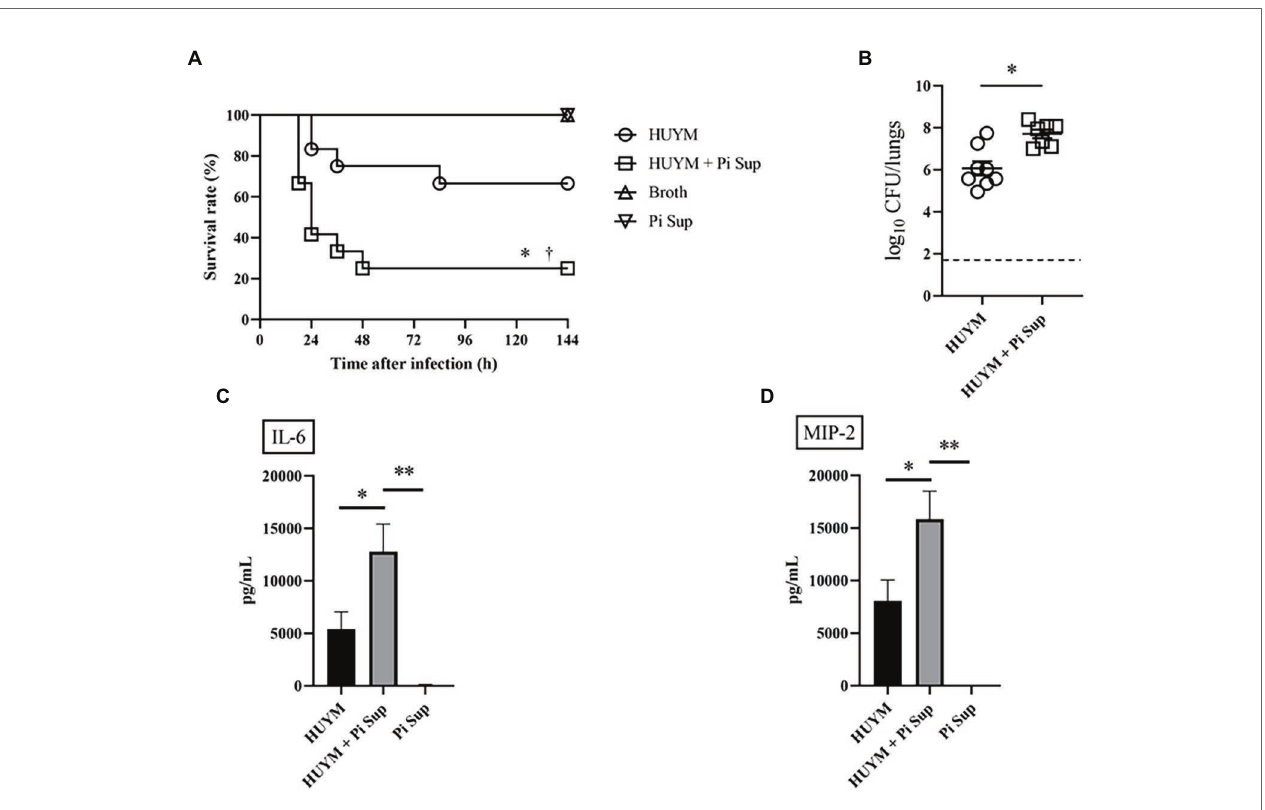
FIGURE 1 | Survival rates (A) and bacterial loads (B) of mice infected with the HUYM methicillin-resistant Staphylococcus aureus (MRSA) strain with/without supernatant of Prevotella intermedia (Pi Sup). O , HUYM-infected mice without Pi Sup; ◽ , HUYM-infected mice with Pi Sup; △ , broth-inoculated mice; and ▽ , Pi Sup-inoculated mice. In (A) * p < 0.05, HUYM-infected mice with Pi Sup vs. control group; † p < 0.05, HUYM-infected mice with Pi Sup vs. HUYM-infected mice without Pi Sup; and n = 6–12 mice/group. In (B) * p < 0.05; bars represent mean bacterial counts, the broken horizontal line represents the lower limit of detection (1.7 log10 CFU/ml of lung specimen). Similar results were obtained from two independent experiments. Changes in inflammatory cytokine levels in BALF: (C) Interleukin (IL)-6 and (D) MIP-2. * p < 0.05 and ** p < 0.005. Data represent the mean ± SEM of 6–8 mice. Similar results were obtained from two independent experiments.